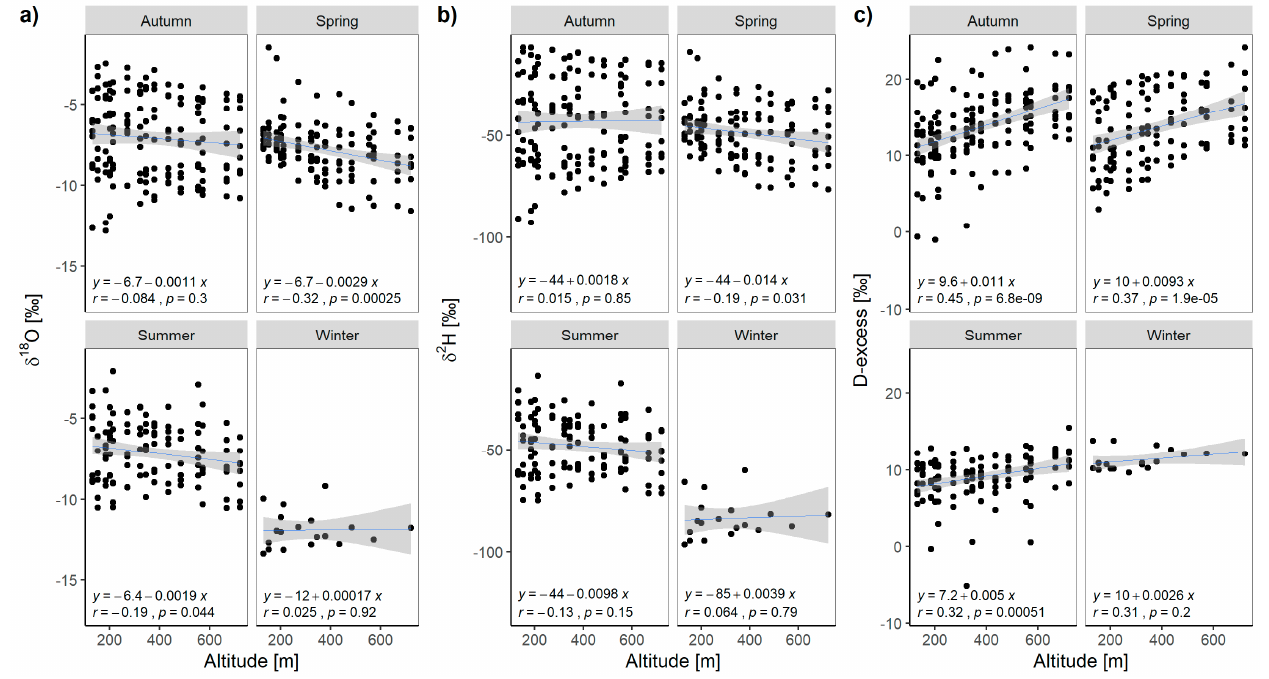
Figure 4. The isotopic values of δ 18 O ( a ), δ 2 H ( b ), and D-excess ( c ) of precipitation along a representative elevation transect separated by seasons. The grey shadings represent the 95% confidence interval of the linear regression lines.